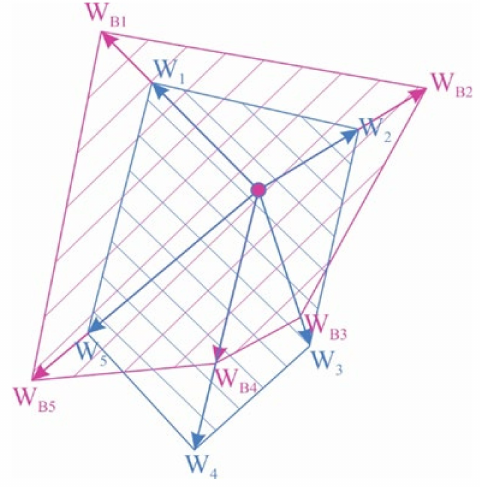
Figure 3. Test stages.